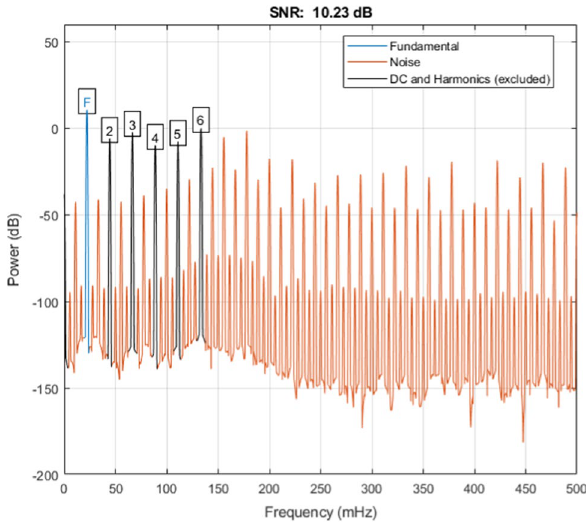
Fig. 6 Implementation of memristor-based Chua’s chaotic